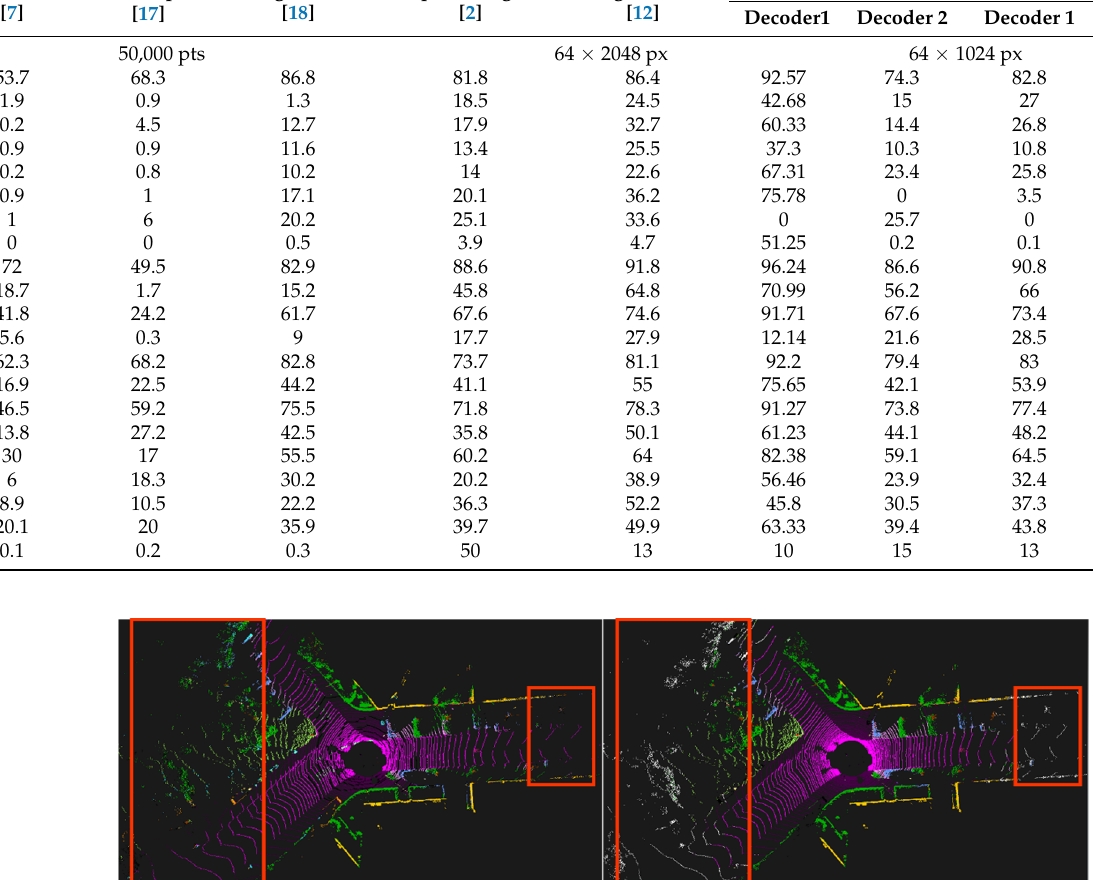
Figure 12. Results before (left) and after (right) applying ABD